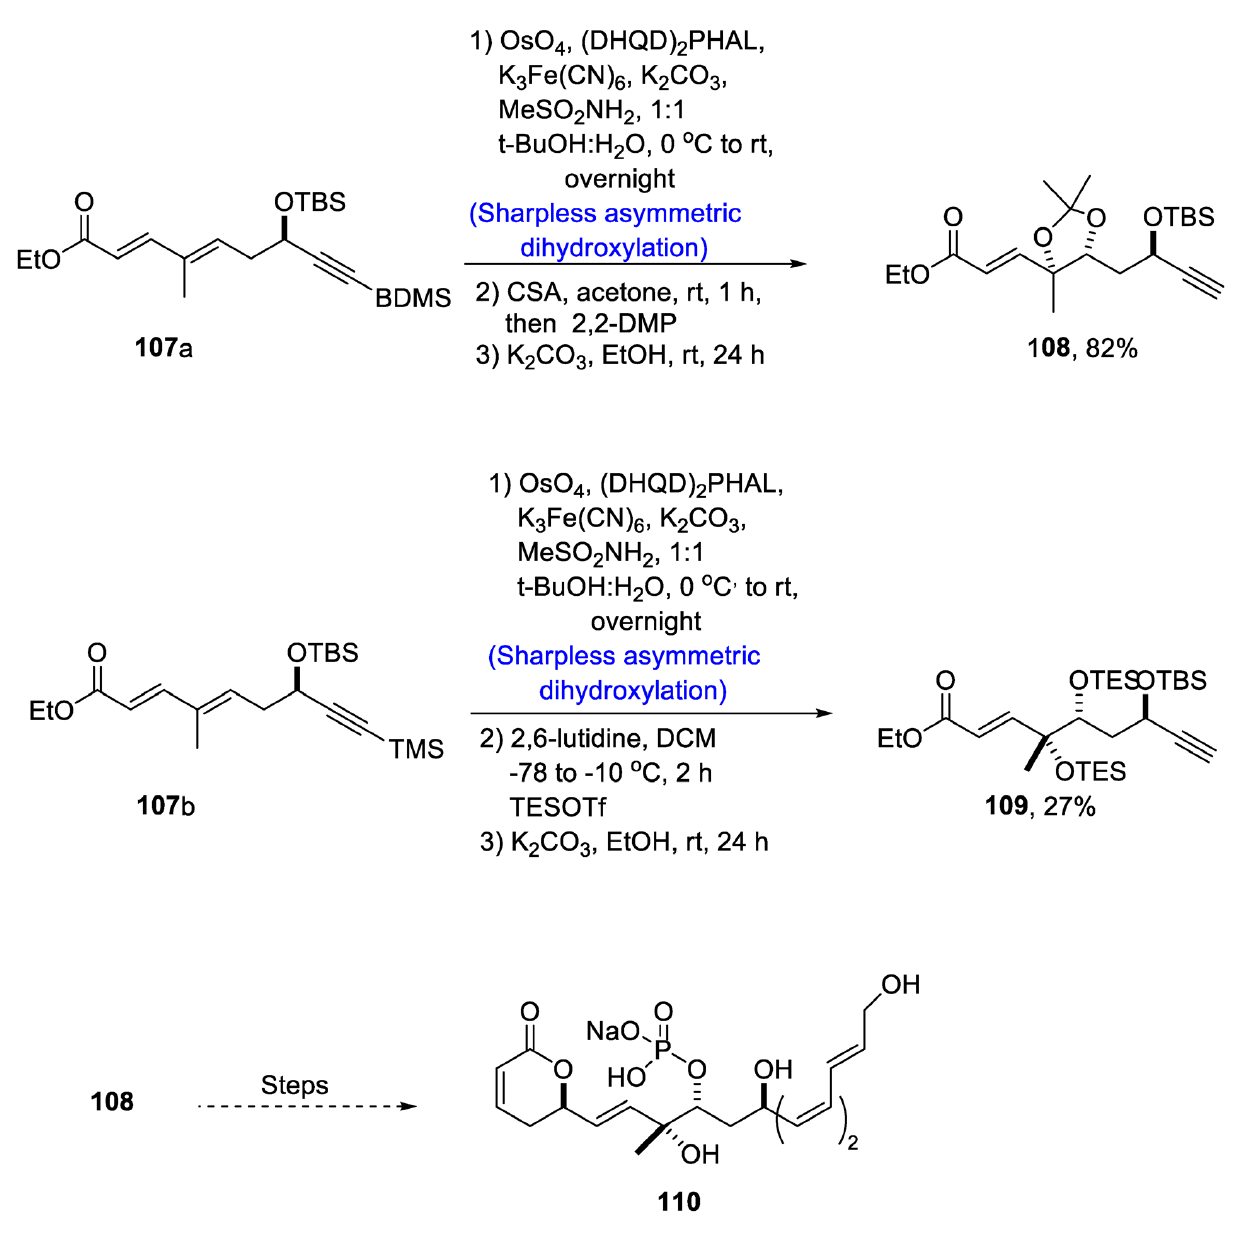
Scheme 16. Synthesis of fostriecin 110